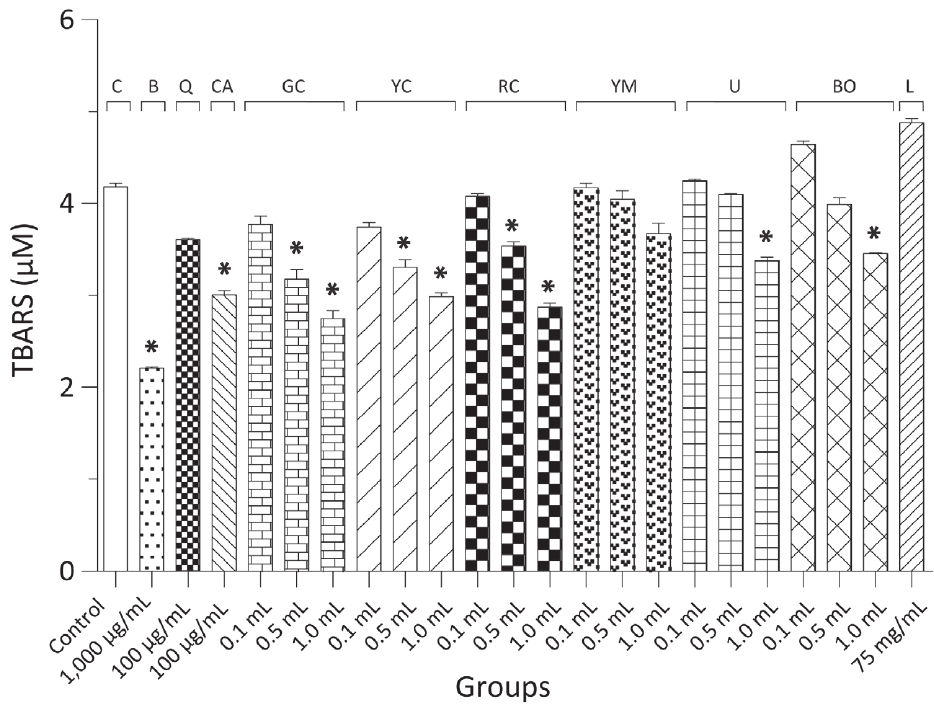
Figure 1 - Effects of four different coconut water varieties, industrialized and the lyophilized water in preventing TBARS formation. (C) Negative control; (B) BHT; (Q) Quercetin; (CA) Caffeic acid; (GC) Green dwarf; (yC) yellow dwarf; (RC) Red dwarf; (yM) yellow Malaysian; (U) UHT processed; (BO) Bottle; (L) Lyophilized. Data are means ± SD (n=10). (*) These data are significantly different when compared with the negative control (p<0.05). For multiple comparisons, ANOVA, followed by Tukey’s test, were